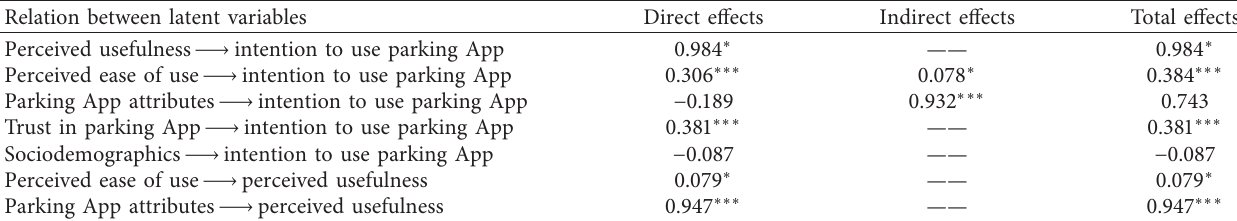
Table 5: Direct, indirect, and total effects between latent